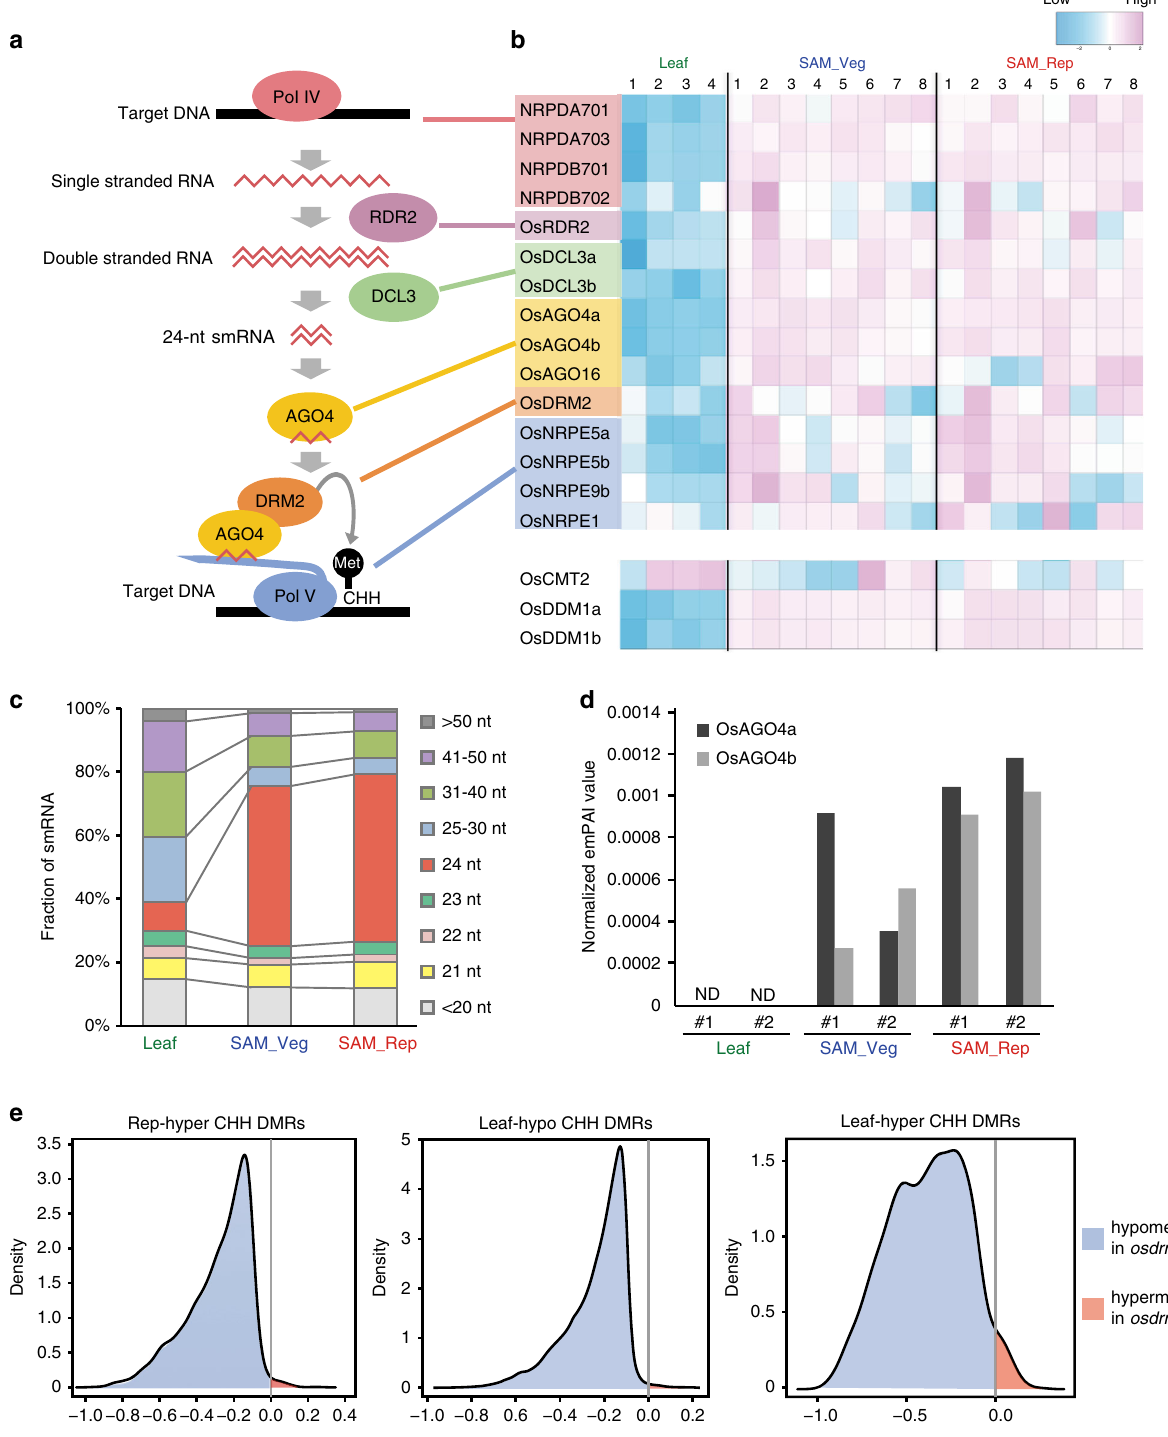
Fig. 4 The RdDM pathway is active in the rice SAM. a Schematic diagram of the canonical RdDM pathway. b Heat map showing the expression patterns of canonical RdDM pathway genes and rice homologs of CMT2 and DDM1 in mature leaf blade (Leaf), vegetative SAM (SAM_Veg), and reproductive SAM (SAM_Rep). Numbers above the heatmap show the number of samples: four, eight, and eight RNA-seq data sets were analyzed for mature leaf blade, vegetative SAM, and reproductive SAM, respectively. c Fraction of smRNAs for each size class relative to total smRNAs expressed in mature leaf blade (left, Leaf), vegetative SAM (middle, SAM_Veg), and reproductive SAM (right, SAM_Rep). The smRNAs were divided into nine classes according to their size. d Exponentially modi fi ed protein abundance index (emPAI) 41 values for OsAGO4a (dark gray) and OsAGO4b (light gray) from proteomic analysis. emPAI is quantitative information proportional to the protein concentration in the samples. ND not detected. #1 and #2 indicate each replicate of the proteomic analysis. e Density plots show the frequency distribution of CHH methylation differences within 50-bp windows of the Rep hyper CHH DMRs (left), Leaf hypo CHH DMRs (middle), and Leaf hyper CHH DMRs (right) between osdrm2 knockout and WT